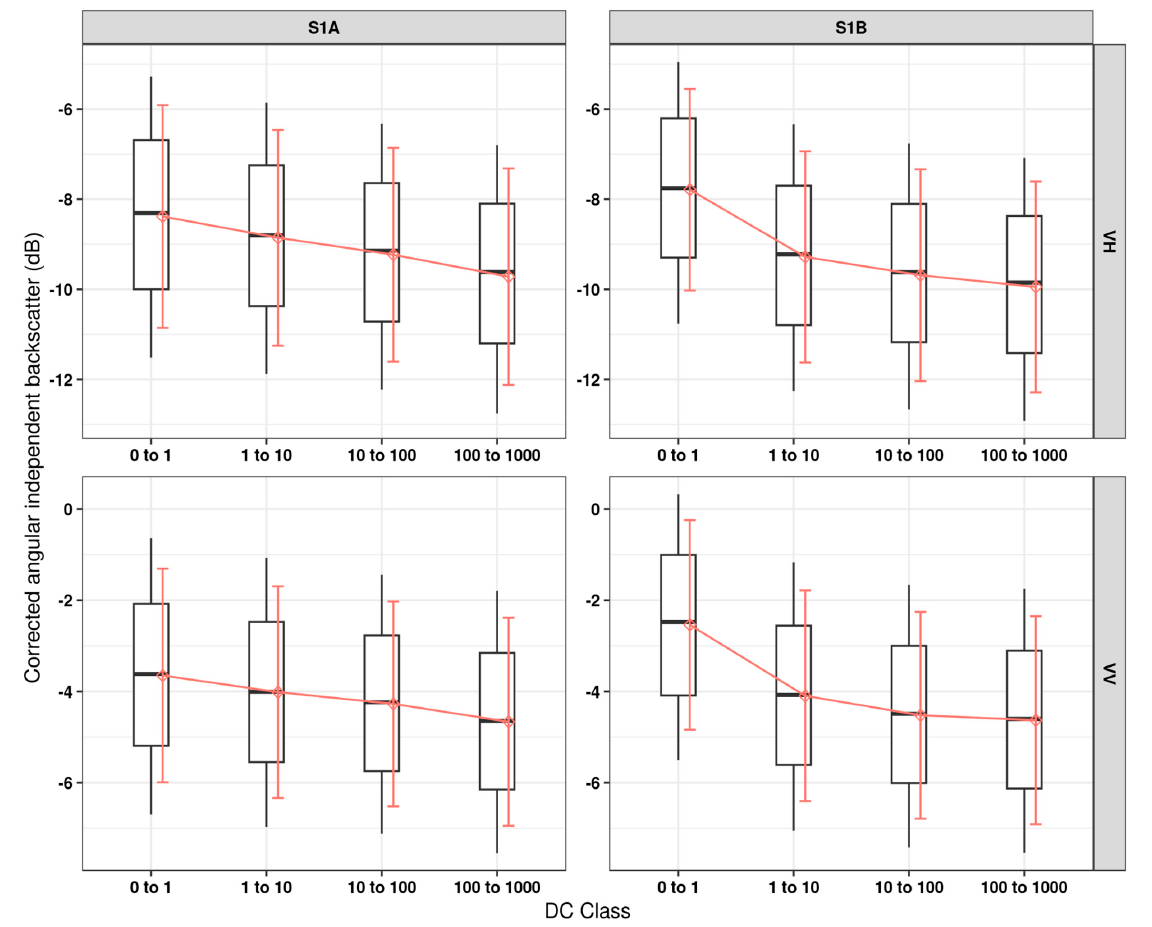
Figure 8. Distribution of corrected backscatter values before fire in fire-affected pixels with the DC classes. Red lines connect the average values, red whiskers are standard deviation, boxplots are the medians and interquartile ranges, with whiskers corresponding to the 10th and 90th percentile.